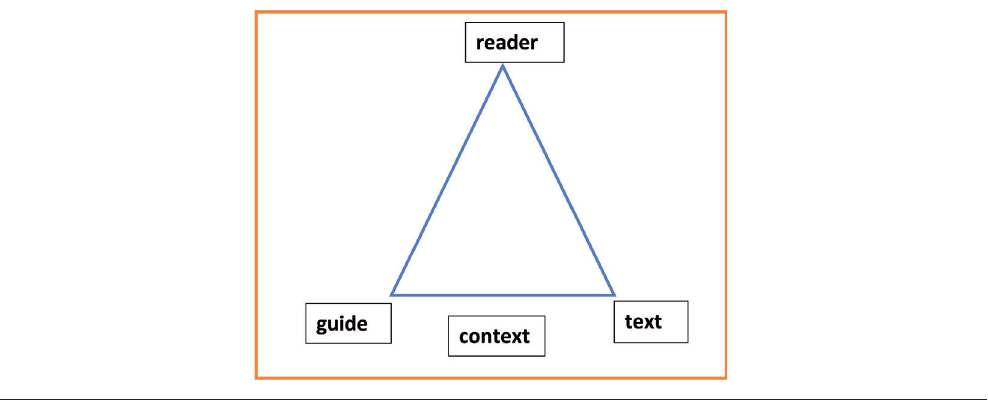
Box 2: Societal partner: Stichting